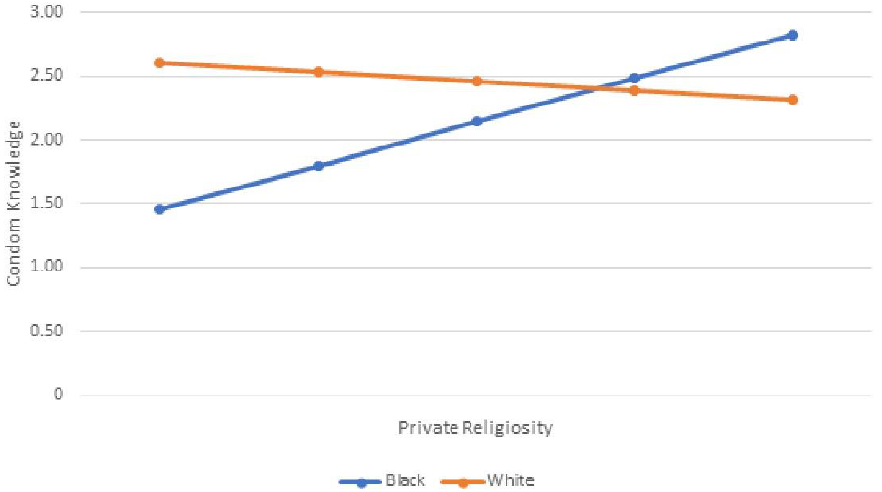
Figure 1. Associations between Private Religiosity and Condom Knowledge, by Race, among the Higher Parental Education Group (RDSL).